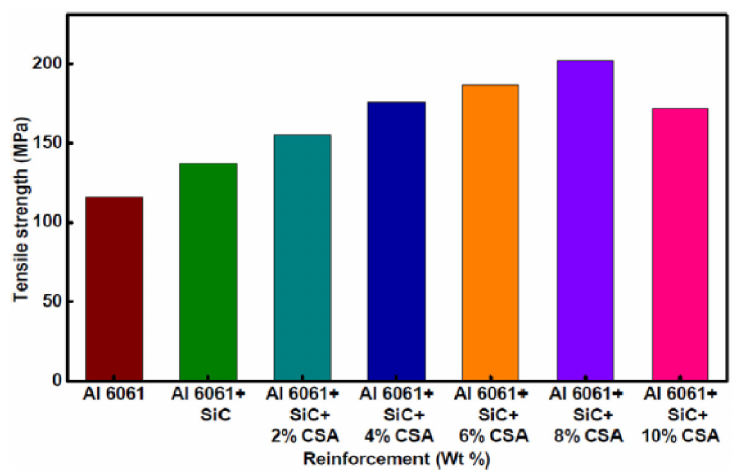
Figure 13. Tensile strengths of Al6061 alloy and its composites [125].